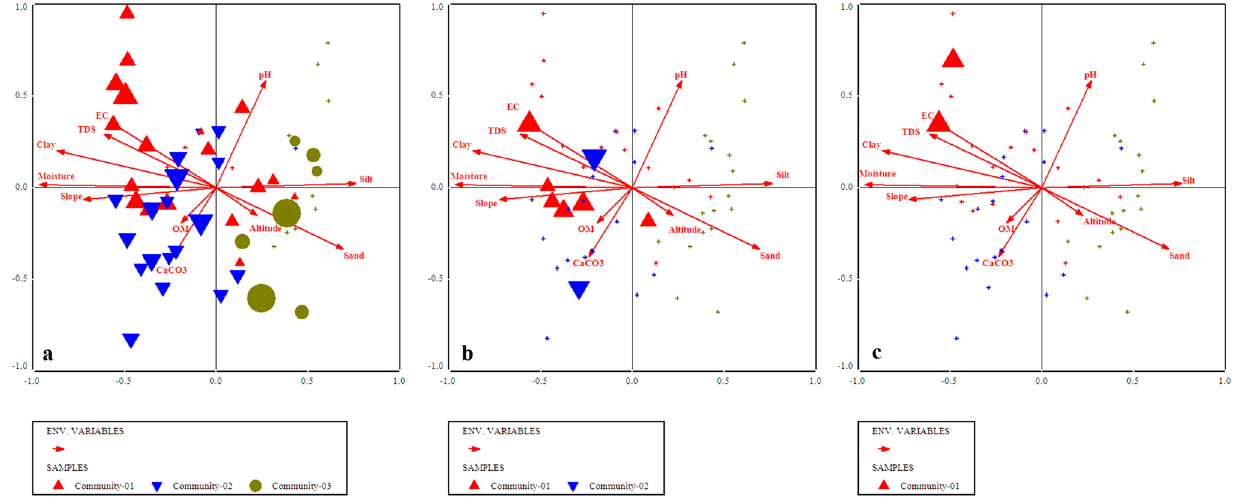
Figure 6. Indicator species biplot for ( a ) Pinus wallichiana, ( b ) Berberis lyceum and ( c ) Impatiens brachycentra top 3 indicators of first plant community in relation to various environmental variables.